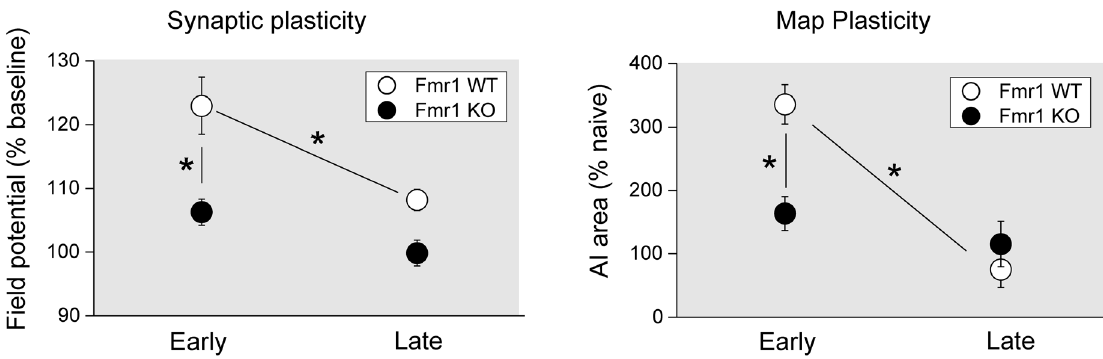
Figure 4. Comparison of synaptic and map plasticity at different ages. Both synaptic (i.e., LTP) and map plasticity (i.e., map expansion following tone exposure) are observed in early window, and only in WT mice but not in Fmr1 KO mice. Map plasticity data adapted from a previous report [12]. Error bars represent SEM. *, p , 0.05.